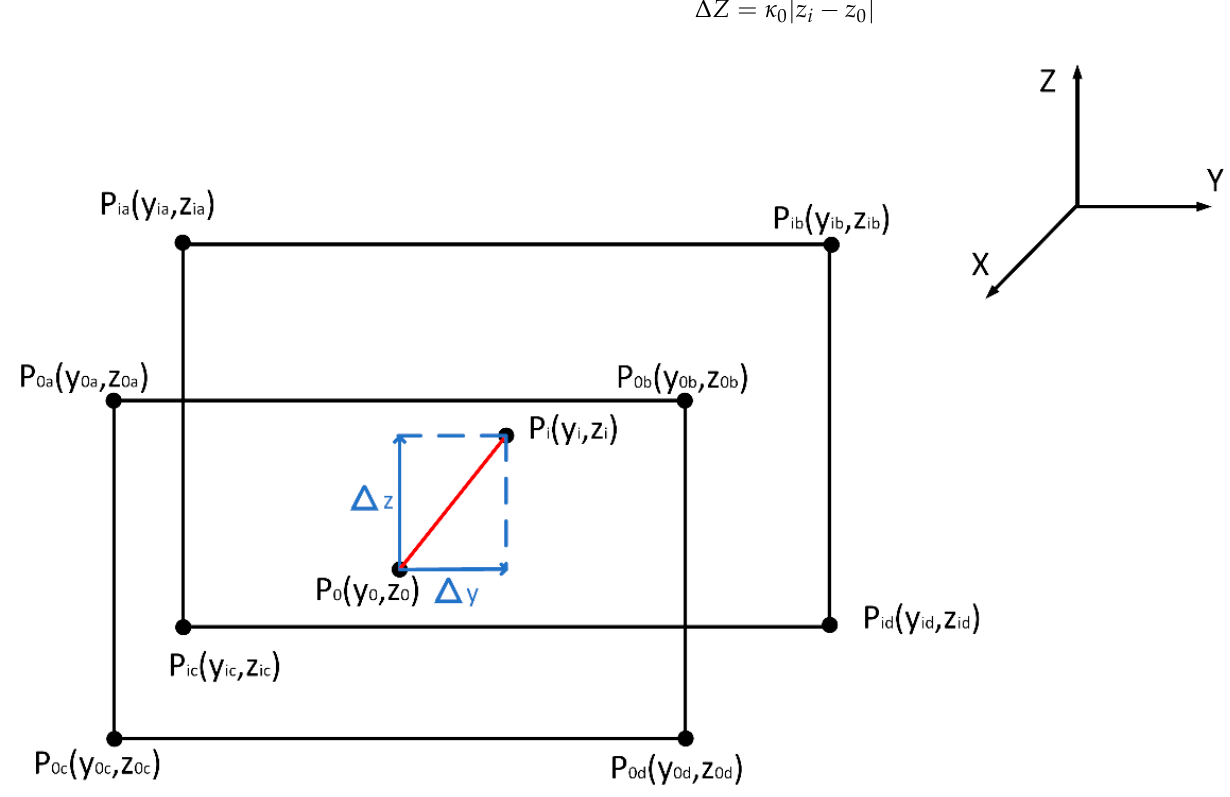
Figure 10. Y, Z offset distance.